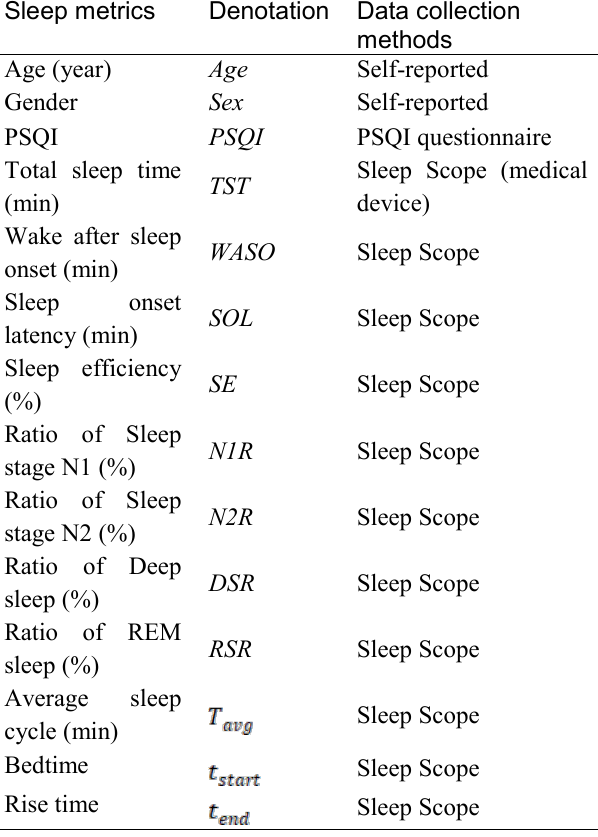
Table 2. Denotations and data collection methods